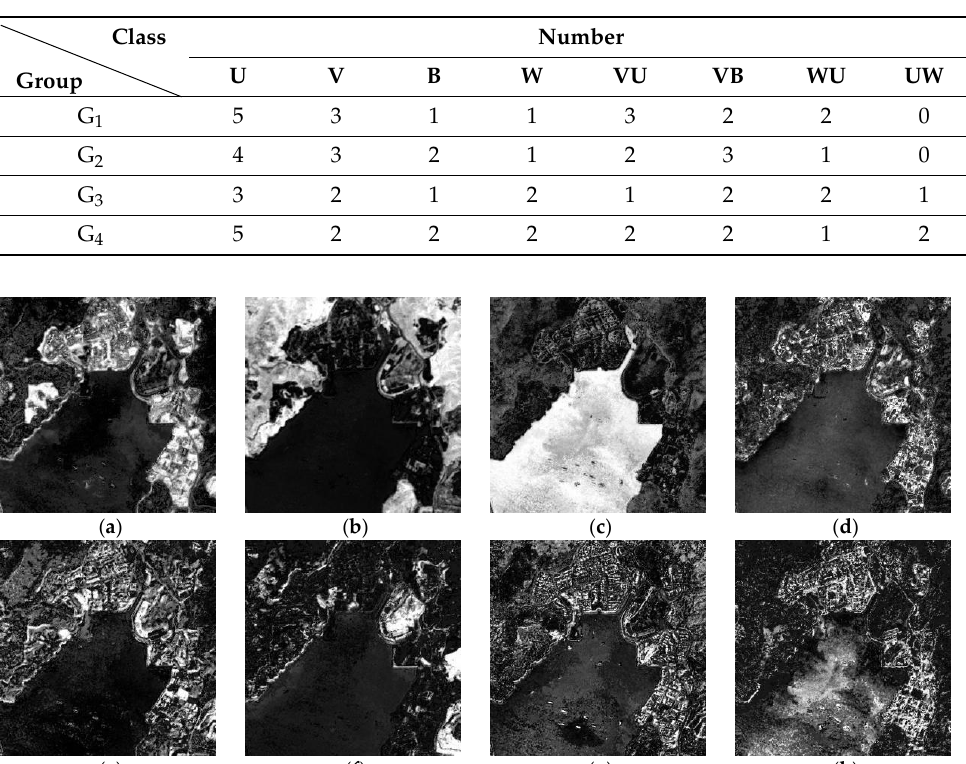
Table 4. The possible endmember spectral numbers in each group.